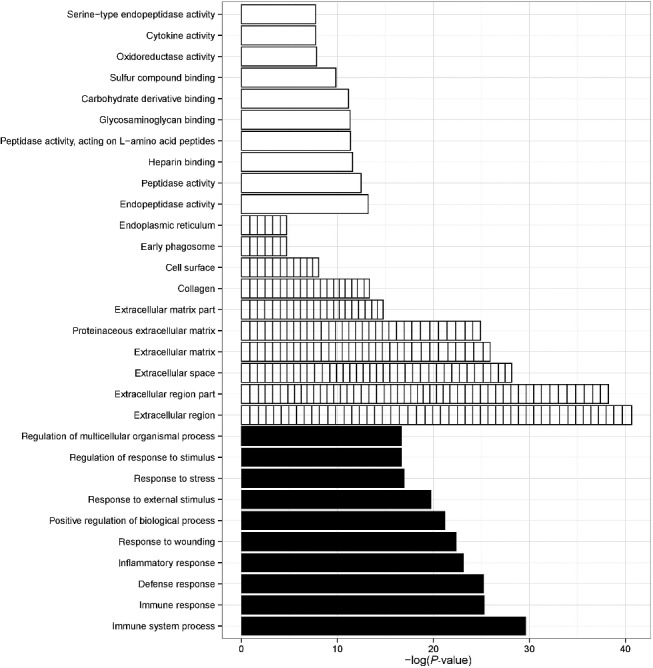
Gene ontology analysis. The GO analysis revealed that the “immune system process”, “endopeptidase activity” and “extracellular region” were the enriched GO terms containing DEGs belonging to BP (white columns), MF (fence columns) and CC (black columns), respectively.